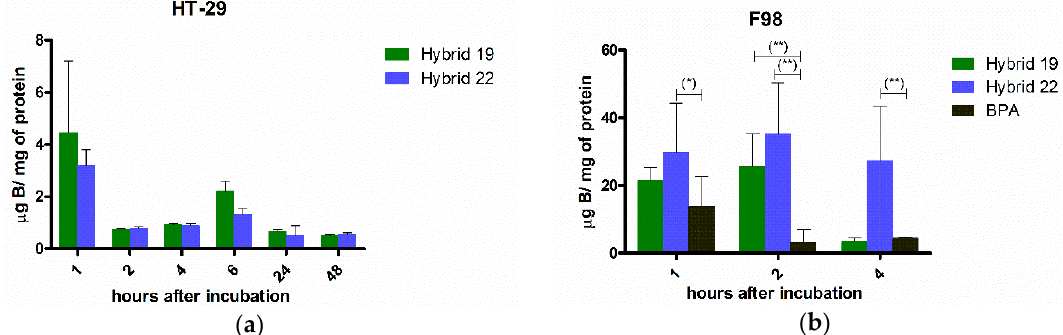
Figure 4. Amount of elemental boron incorporated into studied cells after compounds exposure, ( a ) HT-29 cells treated with hybrids 19 or 22 , at 10 µ M for 48 h, and ( b ) in F98 astrocyte cells treated with in HT-29 cells treated with hybrids 19 or 22 , at 10 µM for 48 h, and ( b ) in F98 astrocyte cells treated hybrid 19 or 22 , at 10 µ M for 4 h, or BPA at 0.925 mM. (*) p < 0.05; (**) p < with hybrid 19 or 22 , at 10 µM for 4 h, or BPA at 0.925 mM. (*) p < 0.05; (**) p < 0.01.